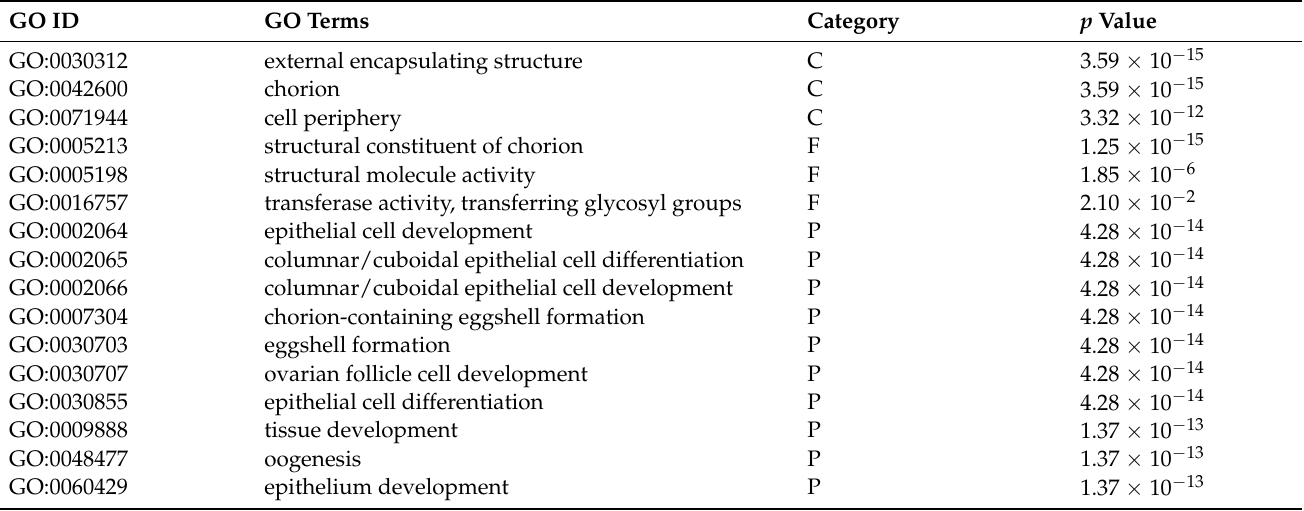
Table 4. GO enrichment analysis for increased abundance proteins in PL after thermal